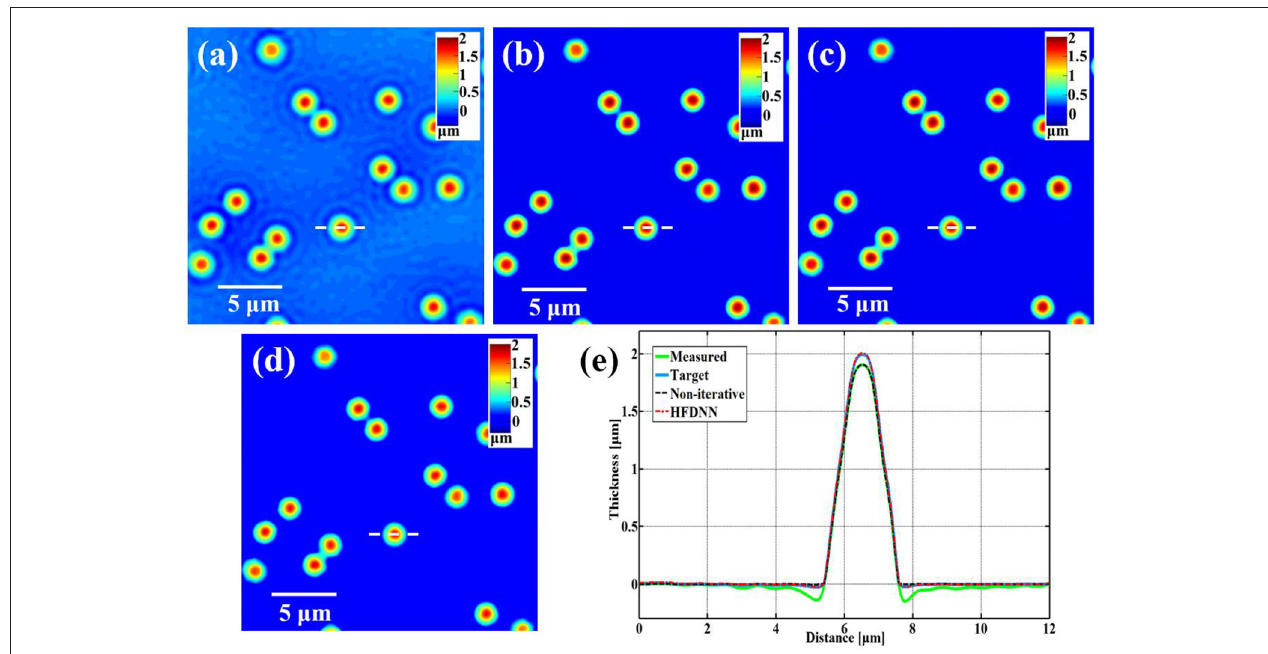
FIGURE 4 | The reconstructed results of standard polystyrene beads. (a) The measured image; (b) the target data; (c) the reconstructed image by our HFDNN; (d) the reconstructed image by the non-iteratitave method —“Non-iterative” in [26]; (e) the thickness profiles along the same diameter of the same bead drawn in (a–d) ; the green curve illustrates the profile of the measured data; the blue curve illustrates the profile of the target data; the red dash curve illustrates the profile of the HFDNN output data; the black dash curve illustrates the profile of the non-iterative reconstruction.